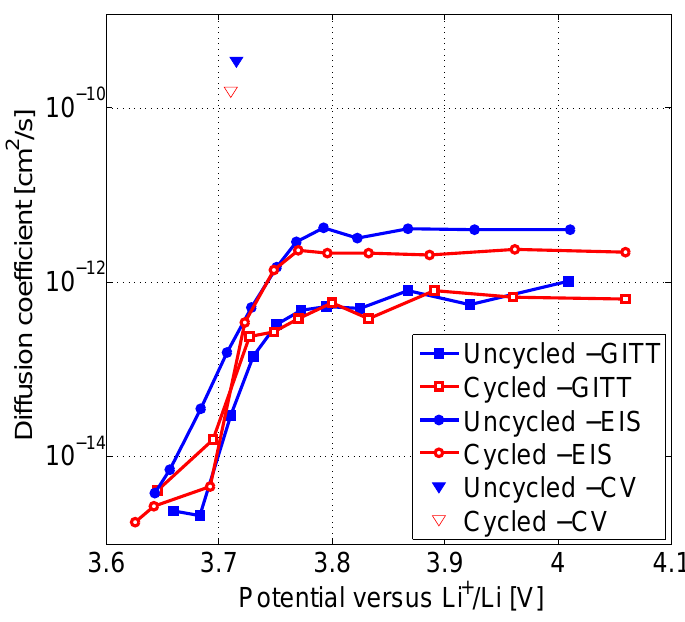
Figure 12. Diffusion coefficients in both electrode types from GITT, EIS and CV characterisations. Table 8 lists the ratios of the diffusion coefficients determined for both electrodes by GITT and EIS techniques compared to CV. These ratios are ranging between 8.56 × 10 − 5 and 5.54 × 10 − 4 . Table 8. Ratios in the diffusion coefficients determined by GITT and EIS techniques compared to